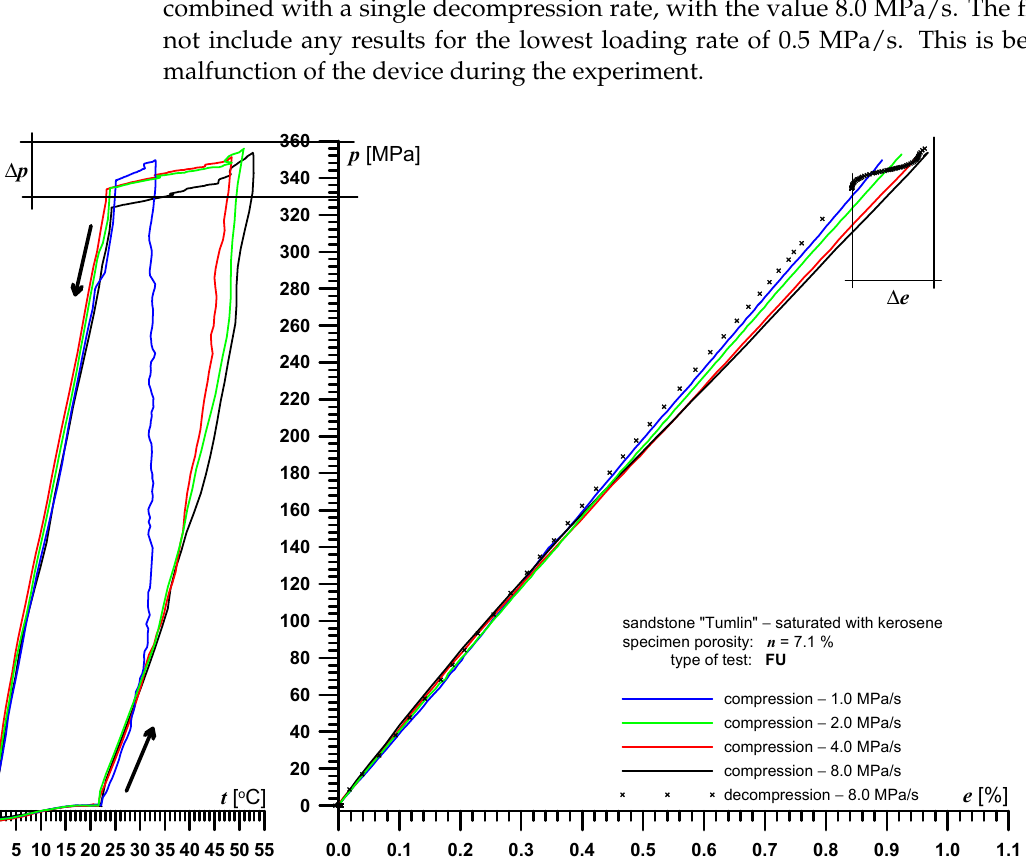
Table 2. Volumetric moduli of compressibility for compression ( K s(c) ) and decompression ( K s(d) ); SU test, Tumlin sand- stone.